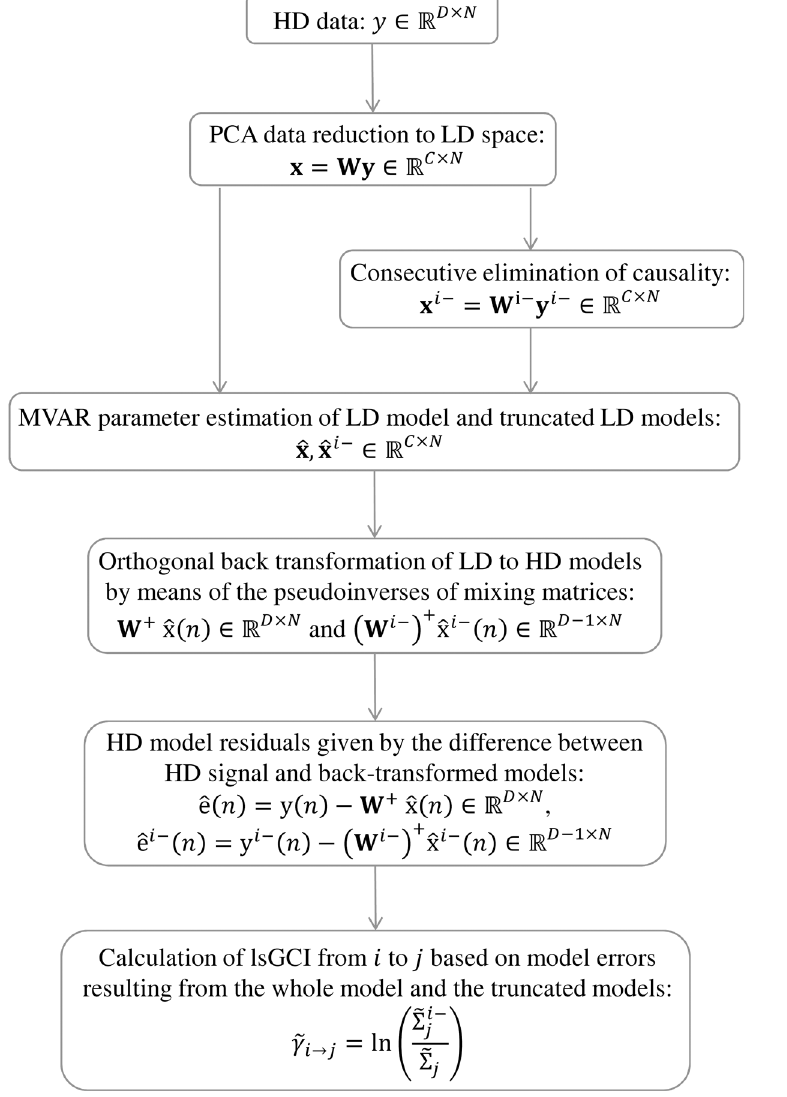
Fig 2. Overview of successive processing steps in the lsGCI